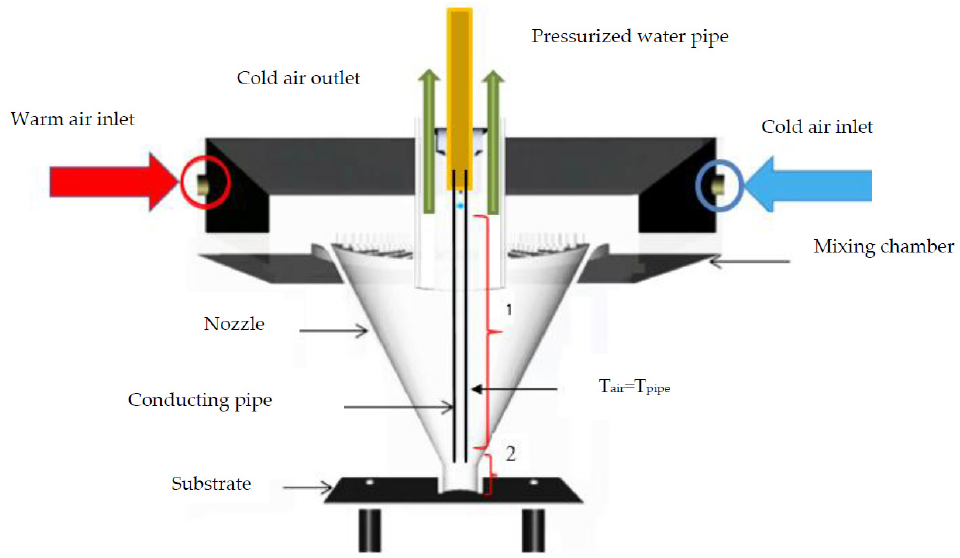
Figure 1. Schematic of droplet accelerator.